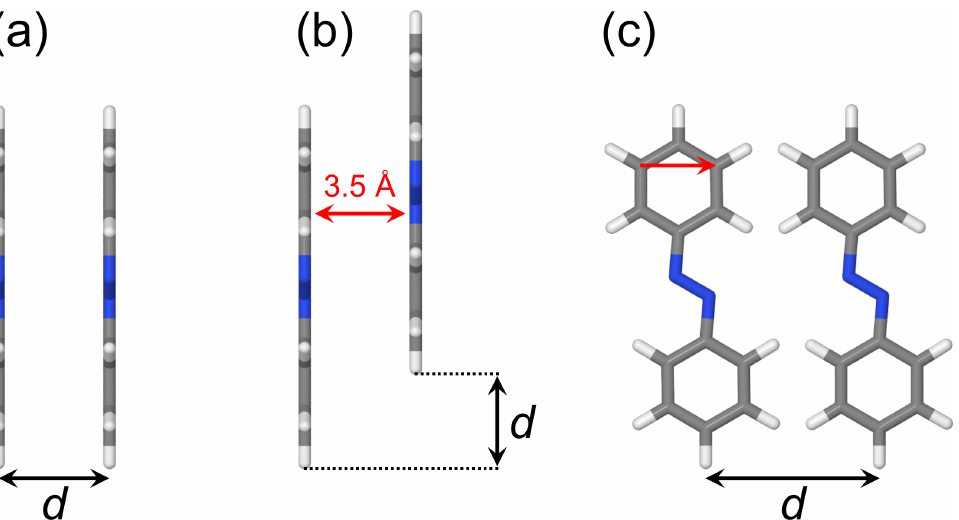
Figure 4. Dimer models studied in the present work. ( a ) Cofacial π -stacked dimer. ( b ) Slip-stacked dimer. ( c ) In-plane dimer. d denotes a coordinate varied. In ( b ), the red arrow shows the distance between molecular planes which was kept at 3.5 Å. In ( c ), the red arrow shows the translation vector calculated as a difference between coordinates of two carbon atoms connected by the